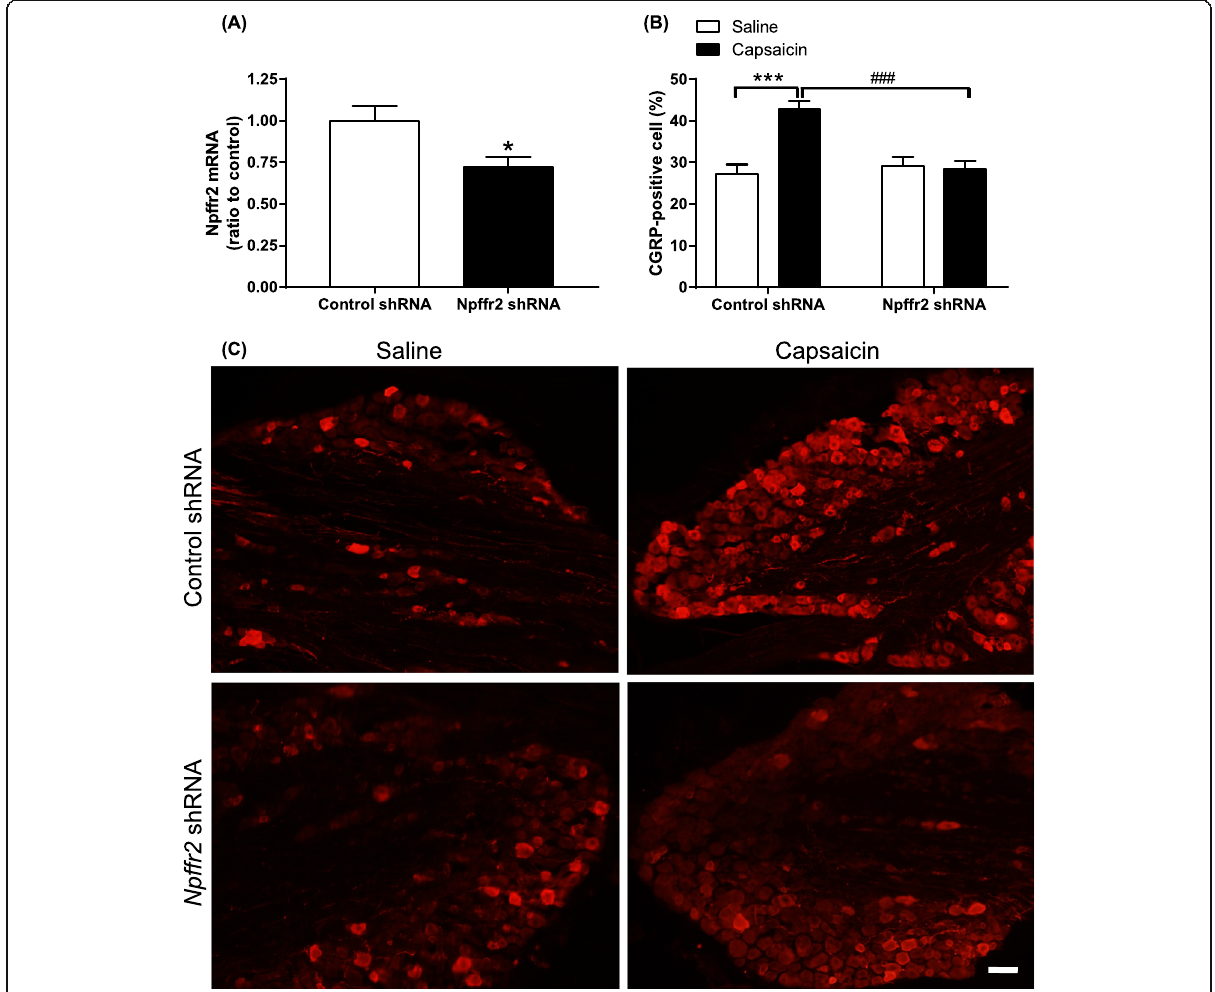
Fig. 3 Npffr2 gene silencing prevents capsaicin-induced CGRP expression in the trigeminal ganglion of mice. One week after mice were intracisternally infused with Npffr2 -a or control LV-shRNA, the animals were treated with capsaicin for 2 h to activate the trigeminovascular pathway. a Trigeminal Npffr2 gene silencing was measured by real-time PCR one week after LV-shRNA infusion. Data are represented as the mean ± SEM and were analyzed by unpaired Student ’ s t -test. * p < 0.05 compared to the control ( N = 4 per group). b The CGRP protein level in the trigeminal ganglion were measured by immunofluorescence staining. The results are presented as percentage of CGRP-positive cell number. Data are represented as mean ± SEM and were analyzed by two-way ANOVA with Bonferroni ’ s multiple comparison test. *** p < 0.001, comparing capsaicin and saline treated groups. ### p <0.001, comparing control and Npffr2 LV-shRNA-treated groups ( N =5 per group). c Immunofluorescence staining of CGRP protein in LV-shRNA- and capsaicin-injected mice. Scale bar =50 μ